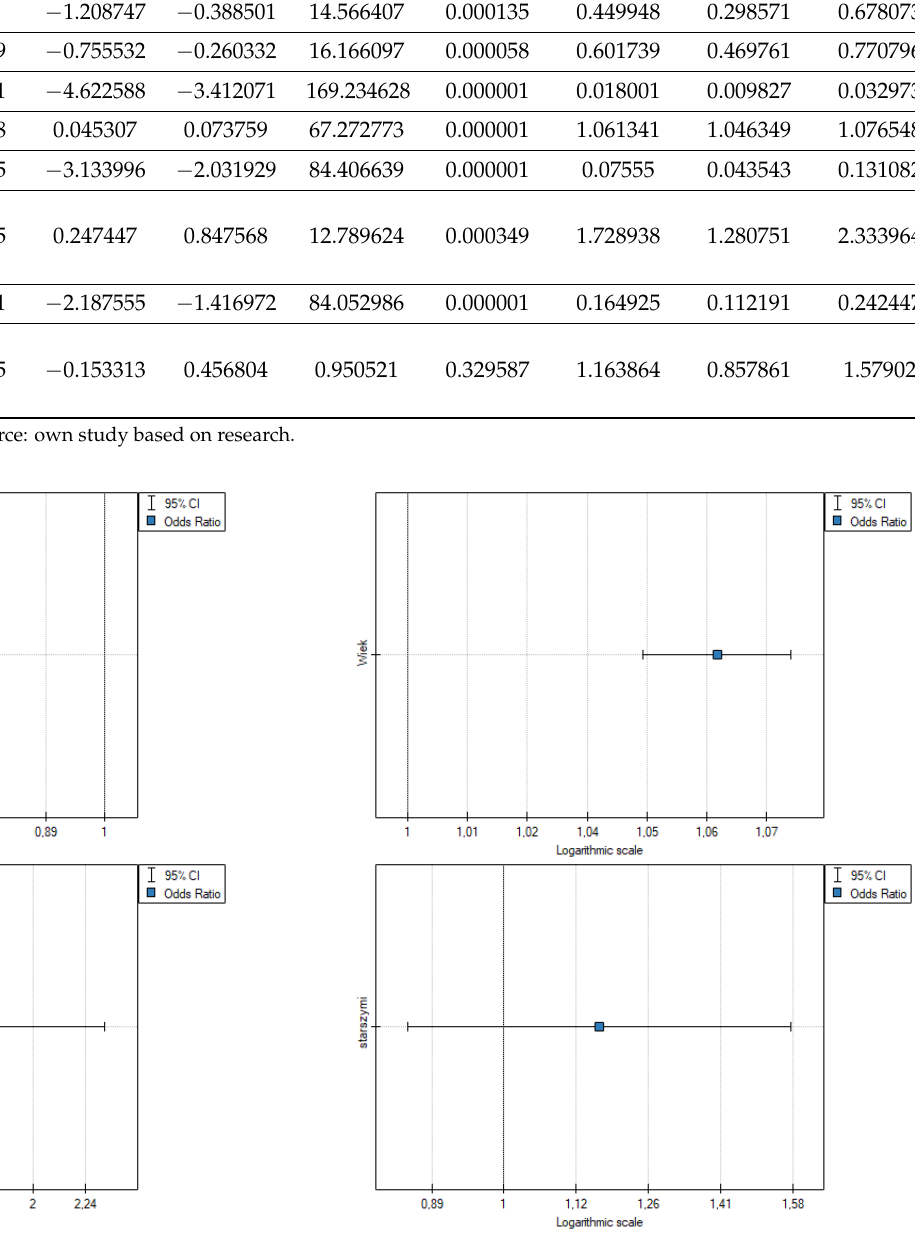
Figure 5. Odds ratios of total fear symptoms and demographic data. Source: own study based on research.